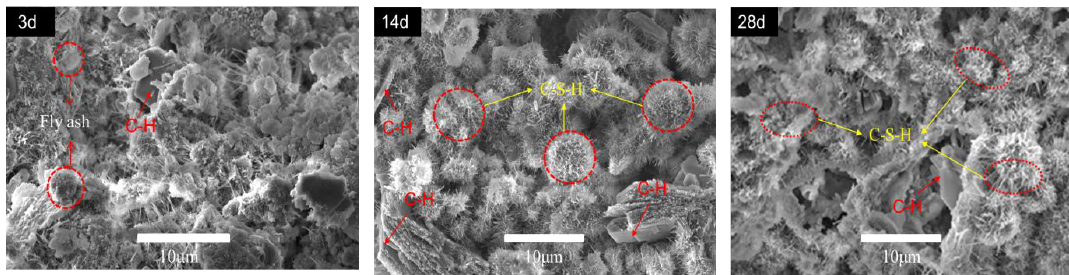
Figure 10. SEM pictures of filling body with ratio of No. Ⅲ in different curing age.